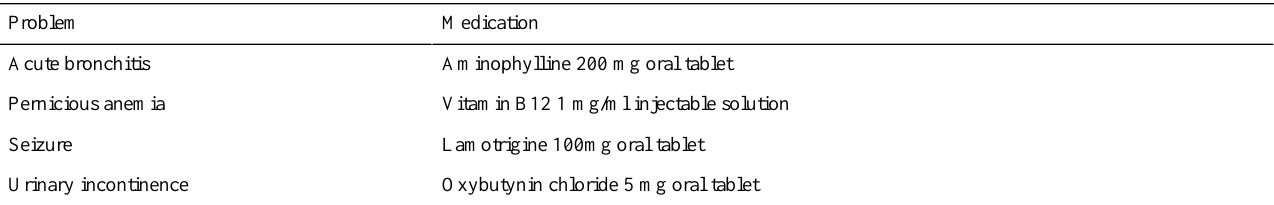
Table 1. Problem-medication linkages found by the patient summarization app on our i2b2 test patient.